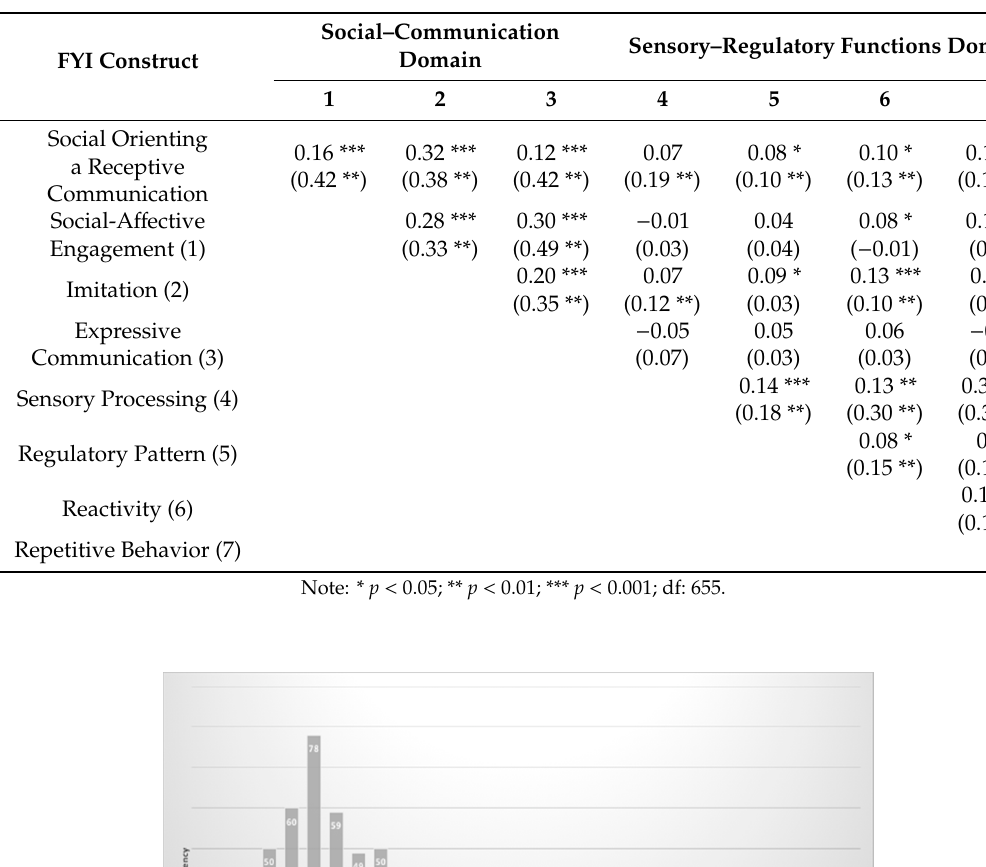
Table 6. Correlations among the FYI 8 constructs on the Italian sample. Between parentheses, the results of the correlations yielded in the American sample by Reznick and colleagues (2007).